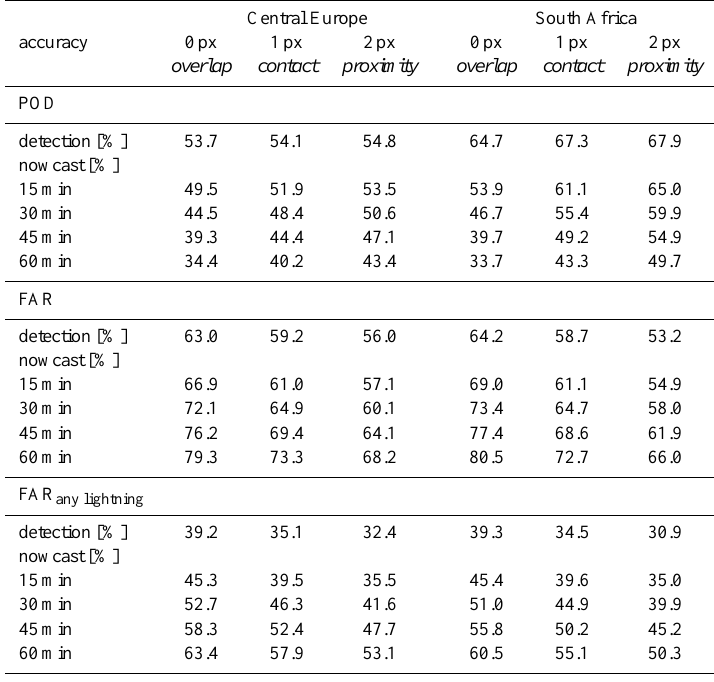
Table A2. Night: object-based validation scores for the current Cb-TRAM night-time detection scheme for mature storms, and the 15, 30, 45 and 60min forecasted objects. Top – POD for intense lightning objects ( > 10flashespixel − 1 15min − 1 ); centre – FAR with regard to intense lightning objects ; bottom – FAR any lightning with regard to objects containing any lightning ( > 0flashespixel − 1 15min − 1 ). Central